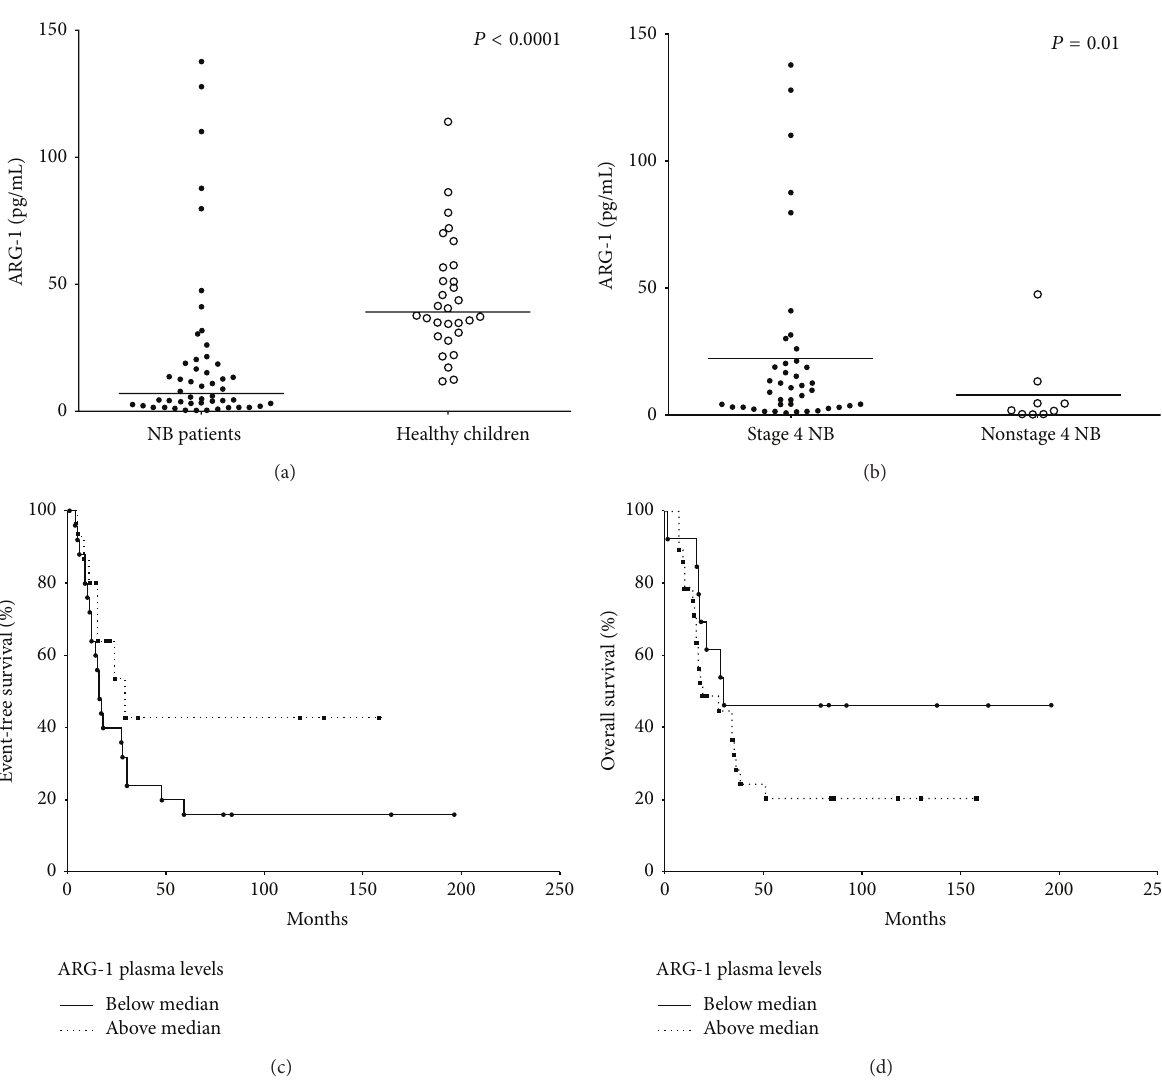
Figure 4: ARG-1 plasma concentration in 57 NB patients and 30 healthy children (a, b), and association between ARG-1 plasma levels of stage 4 patients with EFS and OS (c, d). In (a), all NB patients and controls are shown. In (b), NB patients are stratified in stage 4 ( 𝑛 ∘ = 49 ) and non-stage 4 ( 𝑛 ∘ = 8 ). Results are expressed as pg/mL. Horizontal bars indicated means. 𝑃 values are indicated where differences are significant. Kaplan-Meyer plot of EFS (c) and OS (d) obtained by stratifying the 49 stage 4NB patients according to ARG-1 plasma levels above (dotted line) or below (continuous line) median value. 𝑌 -axes represent % of event-free or alive patients, respectively. 𝑋 -axes represent time of survival